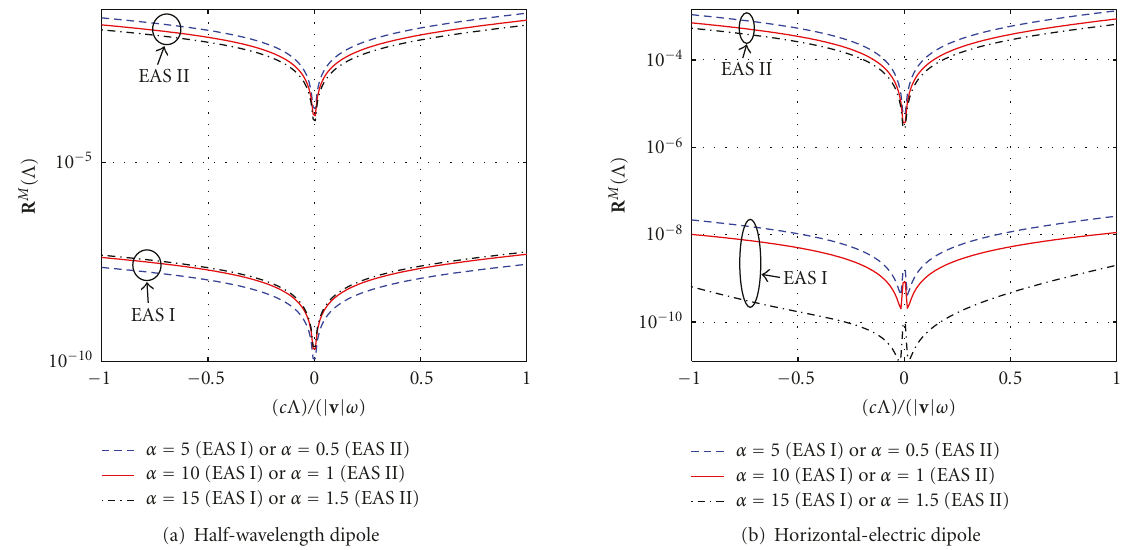
Figure 4: Power spectral density (PSD) for 3D propagation, when MS moves on the positive direction of the x -axis , for stationary CCF ( ω 1 = ω 2 = ω , κ 2 = 0, and m = n = 1), | v | = 50Km/h, for two nonisotropic EAS pdfs (EAS I and EAS II pdfs), and nonisotropic AAS (Laplacian pdf with a = 0 . 25): (a) half-wavelength dipole and (b) horizontal-electric dipole.